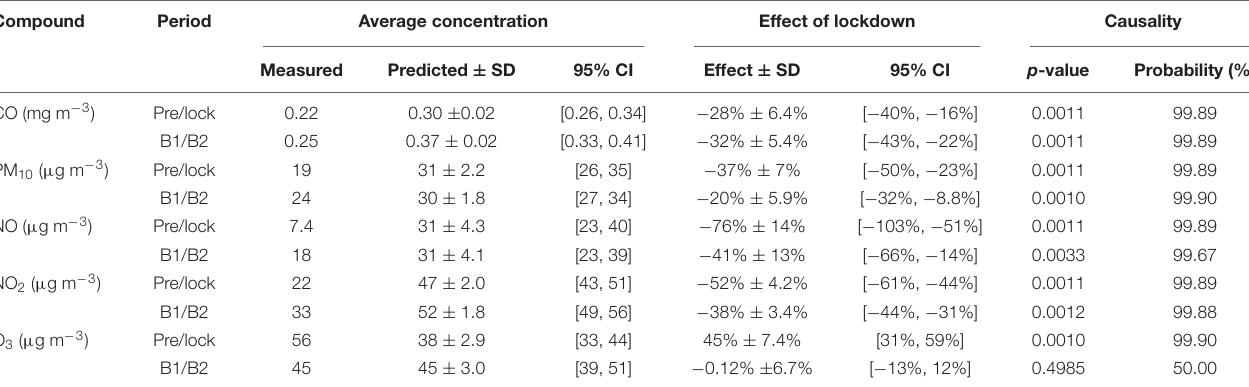
TABLE 3 | Results of the Bayesian model for the air pollutant concentrations in the pre-lockdown/lockdown and B1/B2 periods.